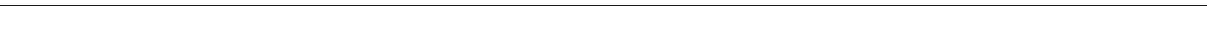
Fig. 7 Nucleolar stress induces dgat-2 expression to promote lipid accumulation. a Confocal microscopy of DGAT-2::GFP in WT, rrp-8 ( kun54 ), rsks-1 ( ok1255 ), and AD-treated worms. Scale bar represents 20 µ m in the panel. b Relative fl uorescence intensity of DGAT-2::GFP quanti fi ed from a . Data are presented as the means ± SD of at least 20 worms for each worm strain. Signi fi cant difference between WT and a speci fi c worm strain, Student ’ s t -test, *** P < 0.001. c Immunoblotting of DGAT-2::GFP. One-day-old WT, rrp-8 ( kun54 ), rsks-1 ( ok1255 ), and AD-treated worms expressing DGAT-2::GFP were collected for lysing and immunoblotting with anti-GFP antibody. d Confocal microscopy of DGAT-2::GFP fl uorescence in WT, rrp-8 ( kun54 ), rsks-1 ( ok1255 ), and AD-treated worms treated with either empty vector (EV) or pha-4 RNAi from L1 to day 1 of adulthood. Scale bar represents 20 μ m. e Relative fl uorescence intensity of DGAT-2::GFP quanti fi ed from d . Data are presented as the means ± SD of at least 20 worms for each worm strain. Signi fi cant difference between WT and a speci fi c worm strain, Student ’ s t -test, *** P < 0.001. Signi fi cant difference between a speci fi c strain treated with empty vector (EV) and pha-4 RNAi, ### P < 0.001. f Schematic diagram of the generation of kun140 and kun141 mutations of dgat-2 using multi-sgRNA-directed CRSPR/ cas-9 technology (upper panel). Deletion of the kun140 and kun141 mutations of dgat-2 was con fi rmed using PCR (lower panel). g Nile Red staining of fi xed 1-day-old adult worms. Representative animals; the anterior is indicated on the left and the posterior is indicated on the right. Scale bar represents 20 μ m. h Distribution of the lipid droplet size (% lipid droplets) measured by Nile Red staining of fi xed worms from g . Data are presented as the means ± SD of 10 animals for each worm strain. Signi fi cant difference between a speci fi c mutant strain without (EV) and with RNAi treatment, Student ’ s t -test, *** P < 0.001, ** P < 0.01, * P < 0.05. i Percentage of triacylglycerol (% TAG) in total lipids (TAG + phospholipids, PL) analyzed by TLC/GC. Data are presented as the means ± SD of four biological repeats. Signi fi cant difference between a speci fi c mutant strain with and without dgat-2 mutant background, Student ’ s t -test, ** P < 0.01, * P < 0.05